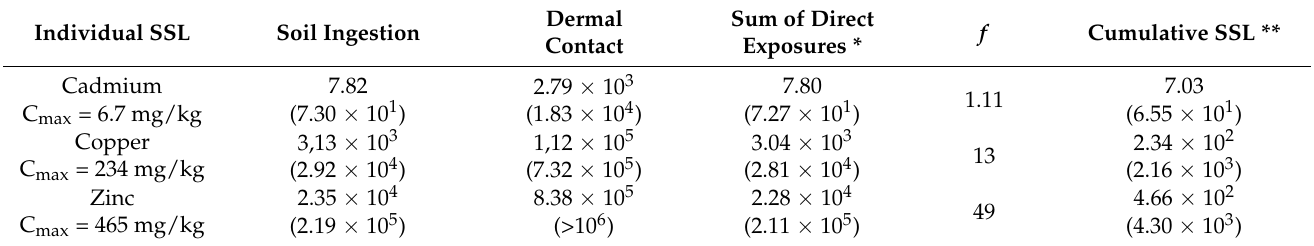
Table 6. Summary of individual SSLs for Cadmium, Copper and Zinc respectively calculated for direct exposure routes, for children and adults receptor (in brackets values for adult). * Calculated according to USEPA [32]; ** SSLs recalculated taking into account the simultaneous presence of all contaminants (applying a corrective factor, f